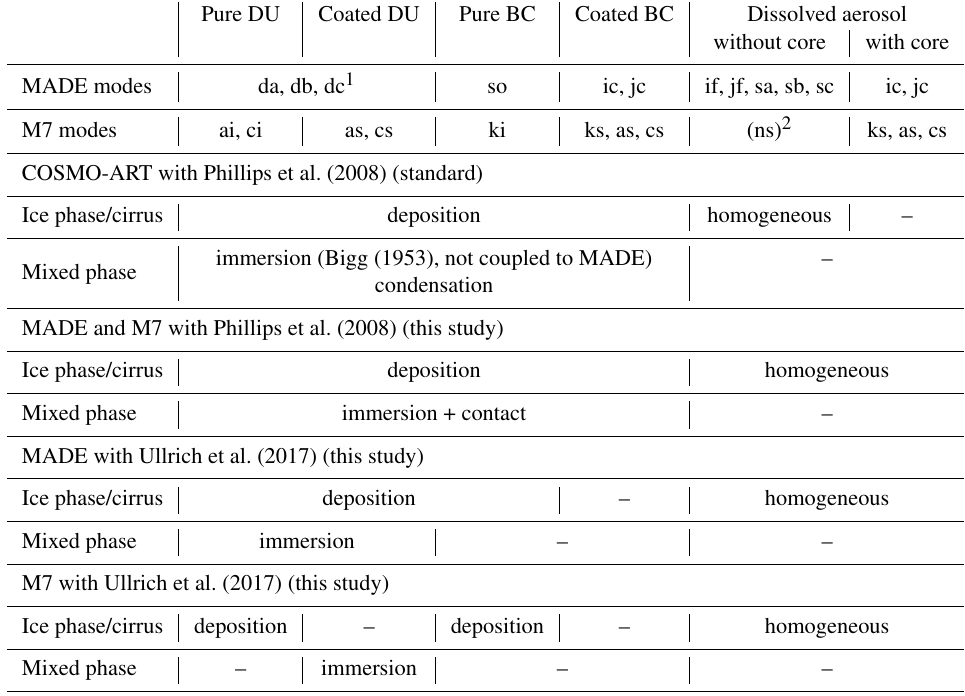
Table 3. Coupling of aerosol modes to ice-nucleation parameterizations. The table summarizes which ice-nucleation modes are considered for the pure dust and soot modes and modes with dust and/or soot core, depending on the aerosol scheme and ice-nucleation parameterization. In the standard setup of COSMO-ART, the condensation freezing parameterization, which takes into account MADE aerosol, is combined with a droplet freezing routine from the cloud microphysics scheme, which is not coupled to MADE. Homogeneous freezing of solution droplets follows Barahona and Nenes (2009b). Pure DU Coated DU Pure BC Coated BC Dissolved aerosol without core with core MADE modes da, db, dc 1 so ic, jc if, jf, sa, sb,